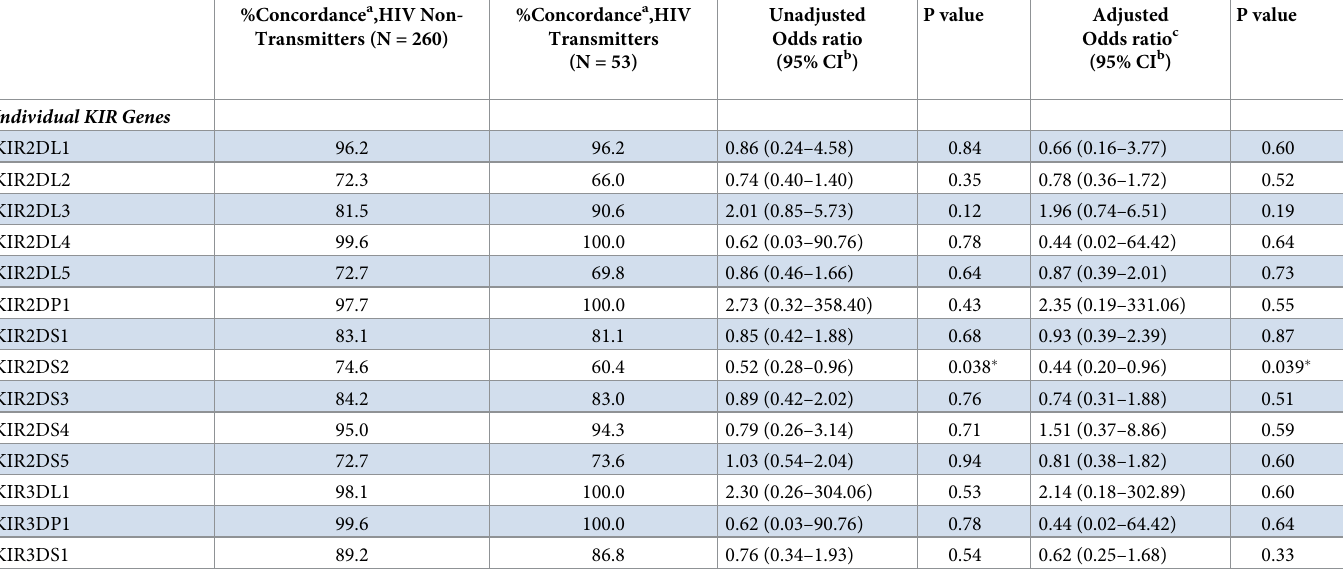
Table 4. Relationship of individual KIR gene concordance with perinatal transmission of